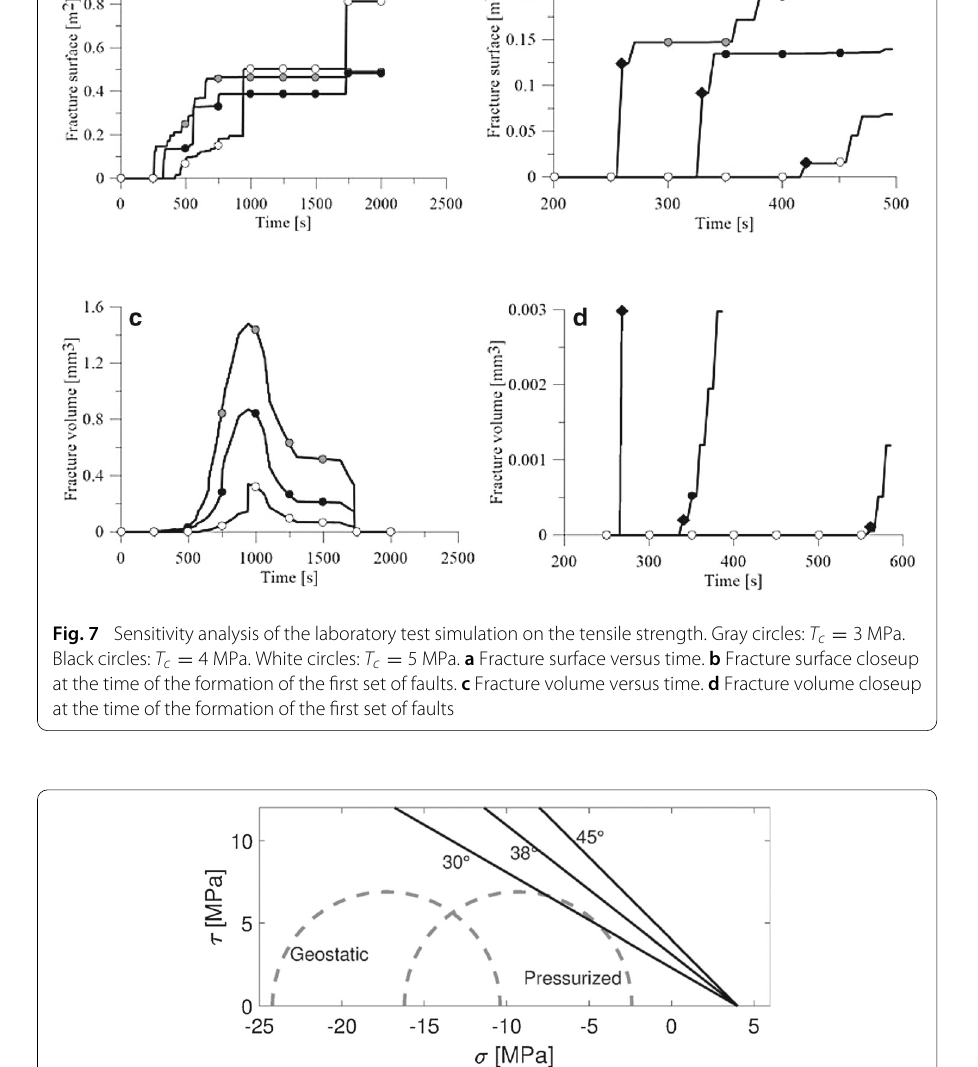
Fig. 8 Sensitivity analysis on friction angle. Failure surfaces in the Mohr plane for friction angles of 30, 38, 45 ◦